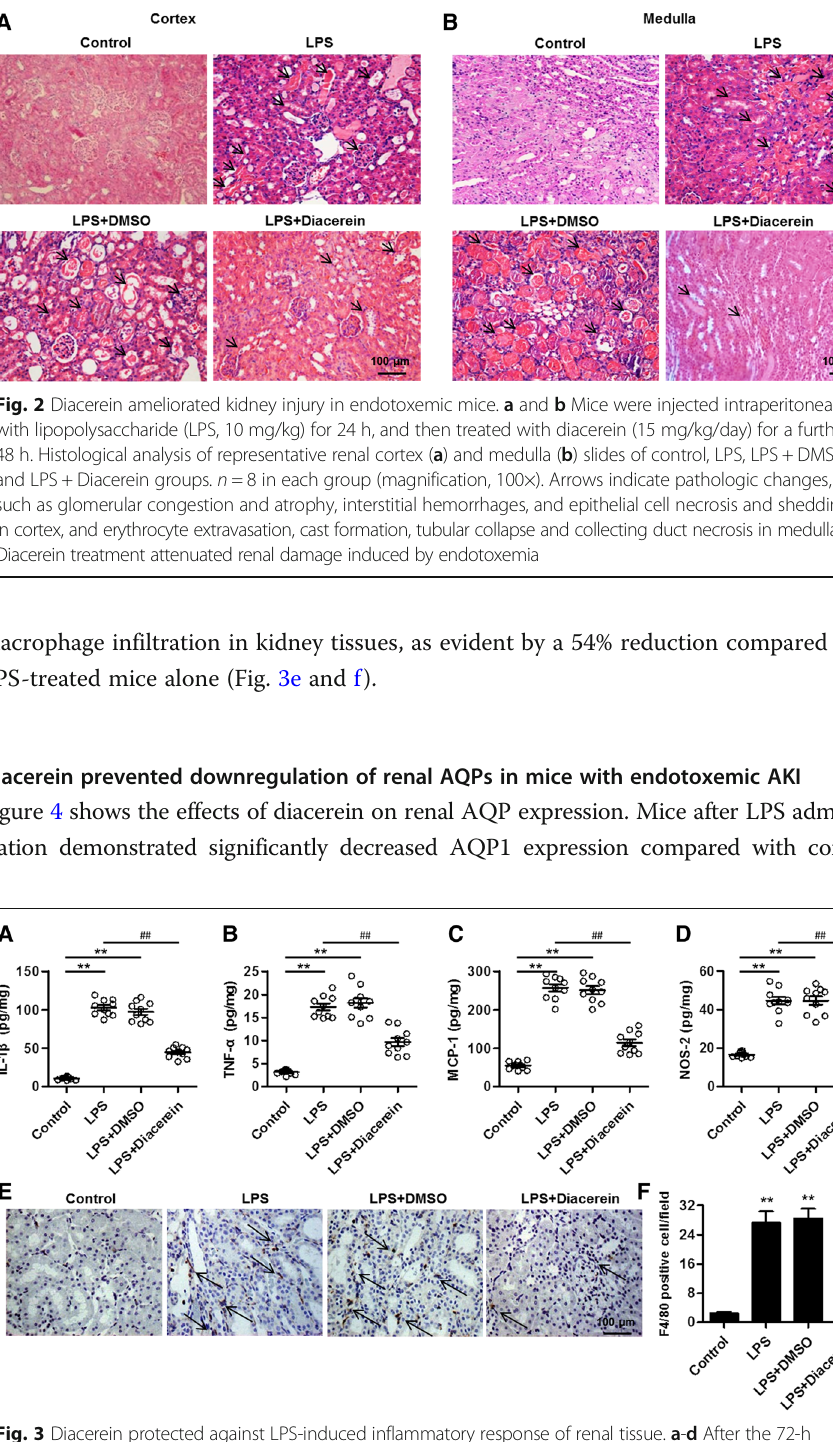
Fig. 3 Diacerein protected against LPS-induced inflammatory response of renal tissue. a - d After the 72-h experimental period, the whole kidneys of each group were harvested. Levels of interleukin-1 β (IL-1 β ) ( a ), tumor necrosis factor- α (TNF- α ) ( b ), monocyte chemoattractant protein-1 (MCP-1) ( c ) and nitric oxide synthase 2 (NOS-2) ( d ) determined by ELISA were inhibited after diacerein treatment. e Immunohistochemical staining of F4/80 in the kidneys isolated from each group (magnification, 100×) (arrows). f Quantitation of F4/80 was determined by computer-based morphometric analysis, which showed that diacerein markedly inhibited infiltration of macrophages in kidney tissues ** P <0.01 vs. control, ## P <0.01 vs. LPS, n =6 in each